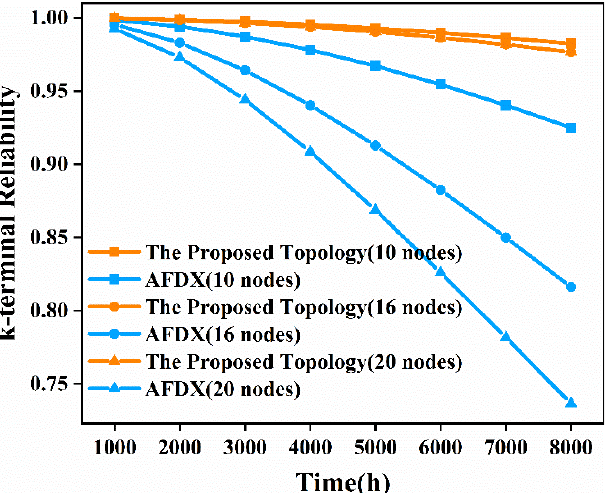
Figure 10. Time ‐ dependent, k ‐ terminal reliability comparison diagram of the proposed topology and AFDX in the three scenarios. AFDX in the three